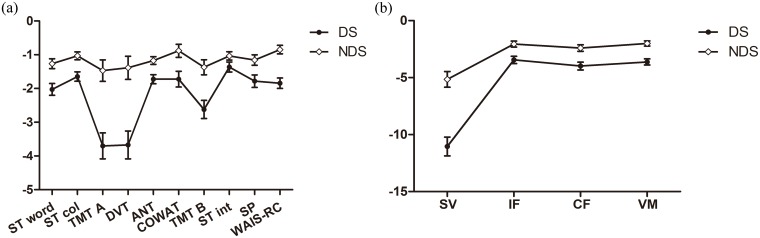
Profile analysis for neuropsychological tests and cognitive domains of DS and NDS groups.Note: Profile analysis for (a) neuropsychological tests and (b) cognitive domains of DS and NDS groups. ST word: Stroop word only; ST col: Stroop color only; TMTA&B: Trail Making Tests A&B; DVT: Digit vigilance test; ANT: Animal Naming test; COWAT: Controlled Oral Word Association test; ST int: Stroop interference test; SP: Spatial processing (Block Design); WAIS-RC: Wechsler adult intelligence scale (Block Design, Chinese version); SV: Sustained vigilance/attention; IF: Ideation fluency; CF: Cognitive flexibility; VM: Visuospatial memory. The error bars on Fig 1 was standard errors.